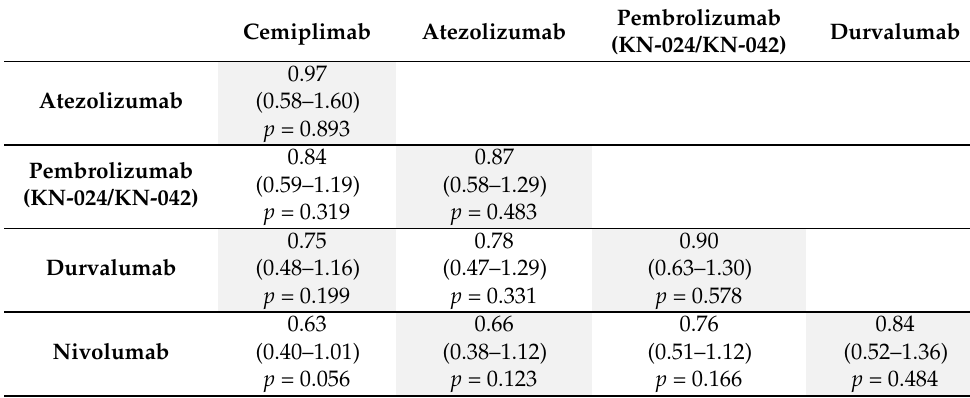
Table 3. Network meta-analysis: OS (HR, 95% CI and p -values are